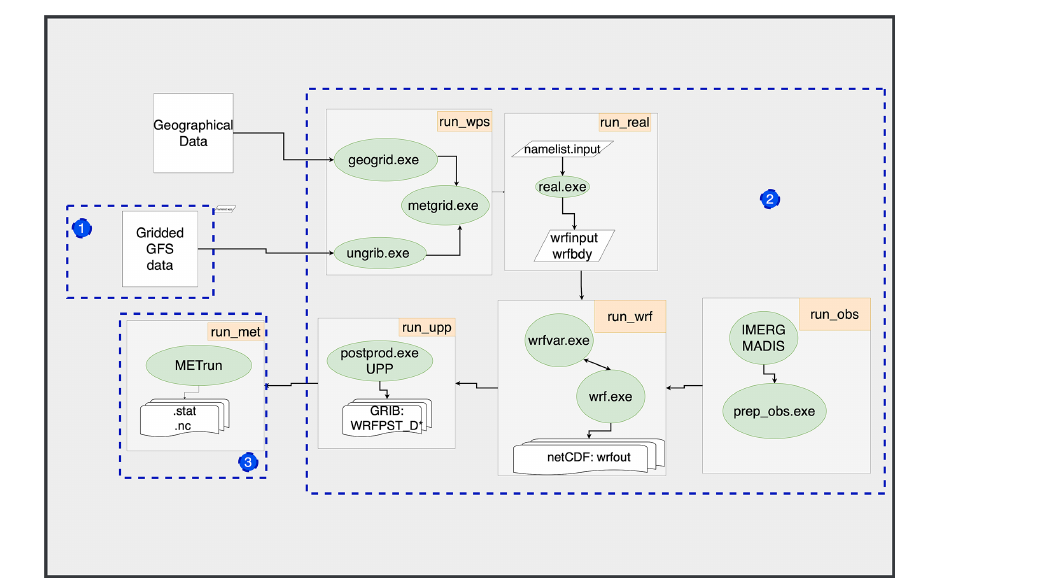
Figure 2. Weather forecasting components (in green). Group of components that belong to the same sub-process are under the same grey box and the sub-process can be seen as run_[name_of_subproces]. With punctuated blue lines, numbered 1, 2 and 3, are the blueprints for the orchestrator. Each blueprint encloses a number of components of the model.